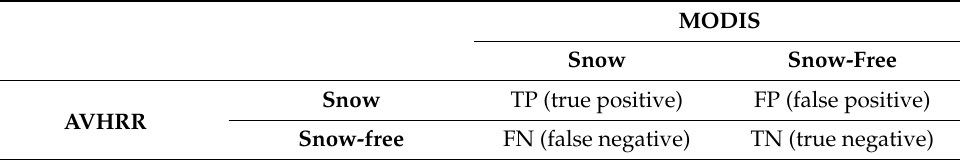
Table 2. Confusion matrix to determine classification accuracy with MODIS